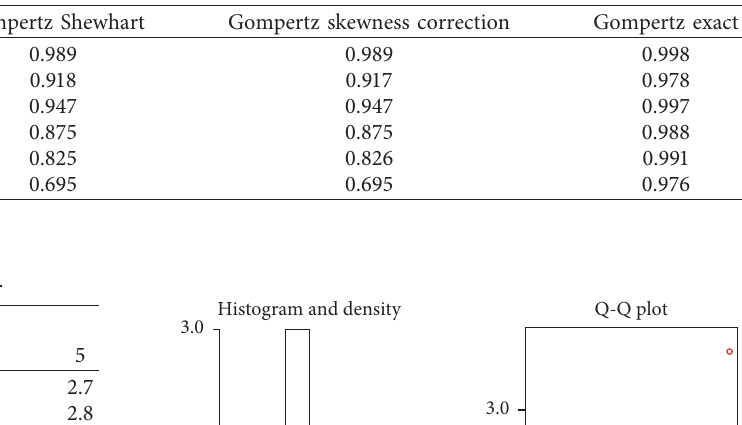
Table 2: Coverage probabilities.